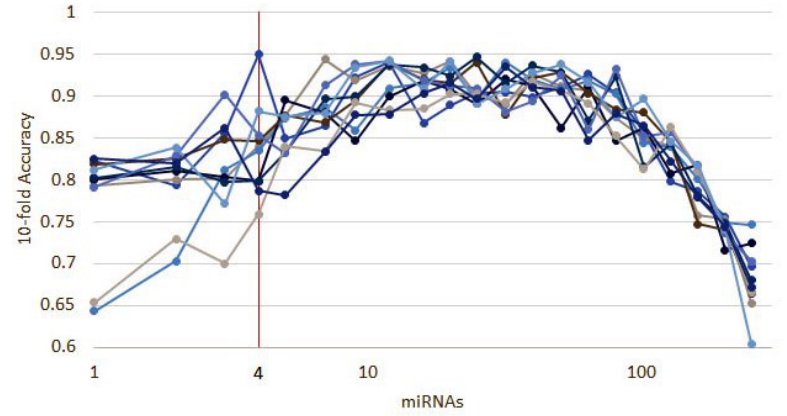
Figure A2. Ten runs of the heterogeneous ensemble recursive selection algorithm: From the 10 runs, the highest accuracy is given by 4 miRNAs: hsa-mir-486-3p, hsa-mir-21, hsa-mir-1285, hsa-miR-708 and hsa-mir-638.